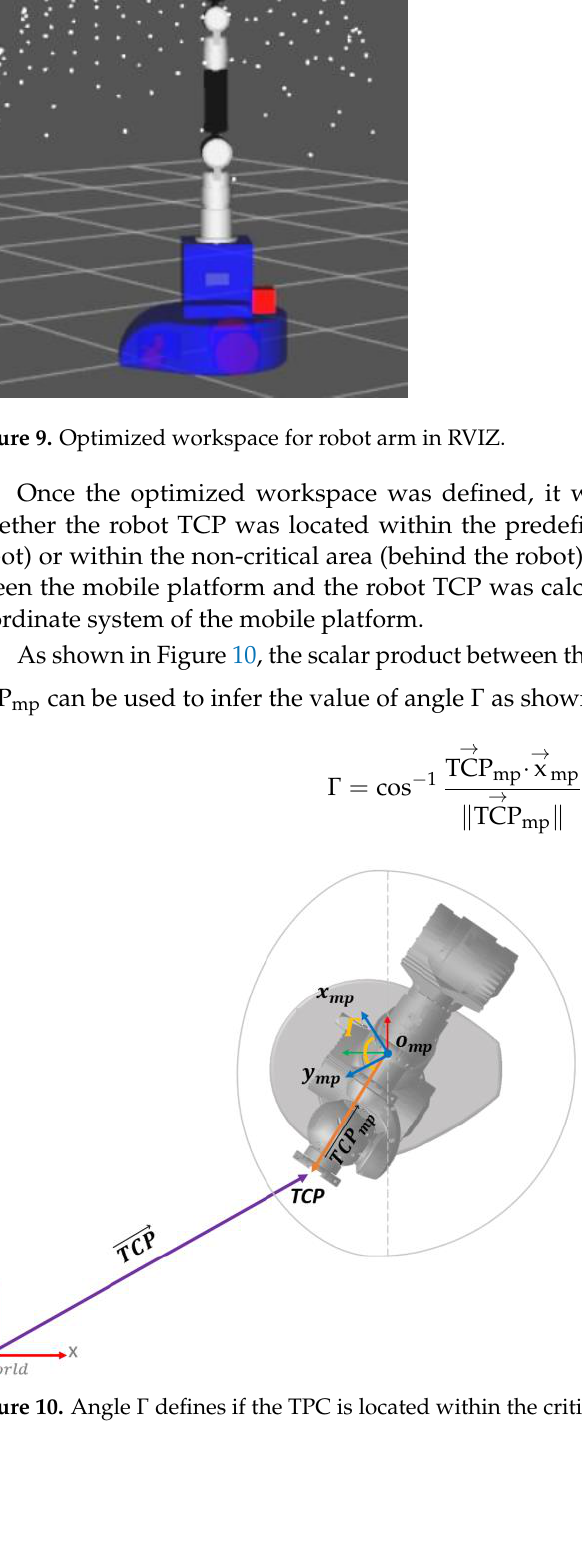
Figure 8. Estimation of the ellipsoid critical radius under static conditions for different angle con- figurations β and ϒ , based on the parameters obtained from CAD volume model of the mobile ma- nipulator.